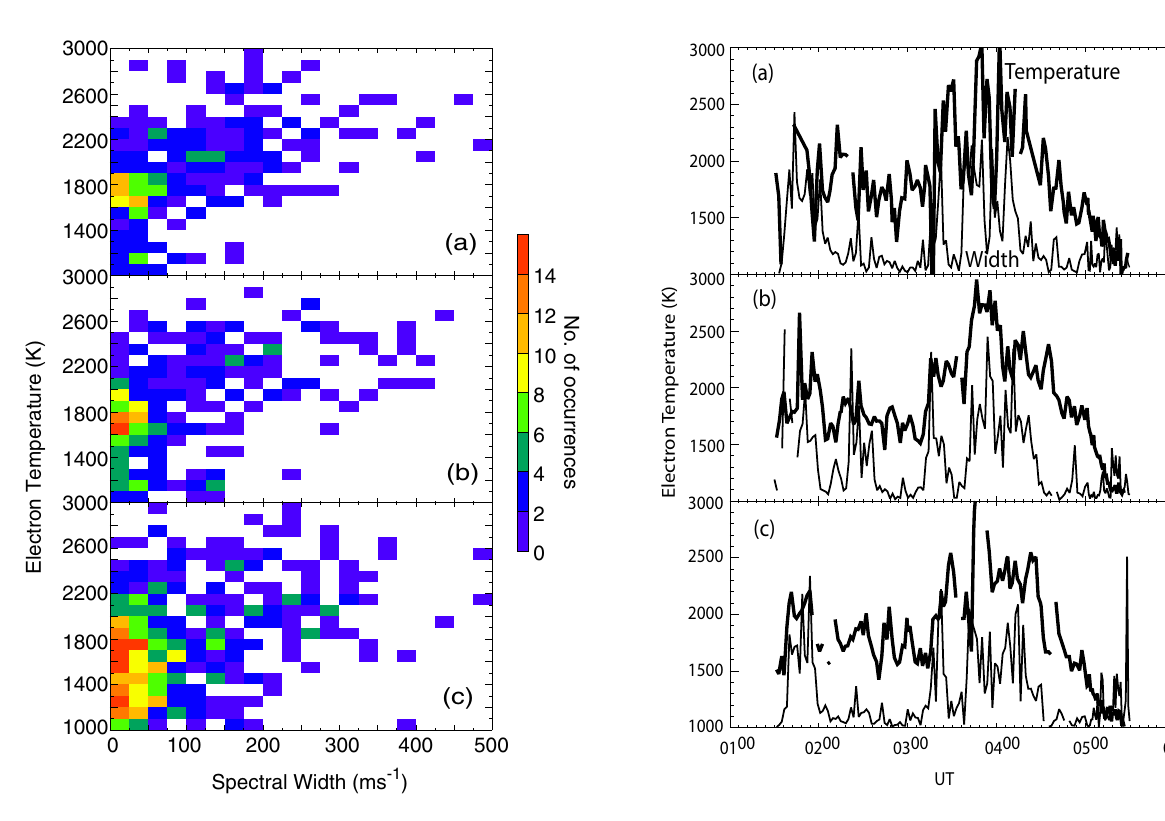
Fig. 8. Scatter plots of electron temperature from the incoherent scatter radar data against spectral width from CUTLASS Finland. The data used has been restricted to between 71 ◦ N and 72 ◦ N. The colours indicate the frequency of observations within the bin they outline.